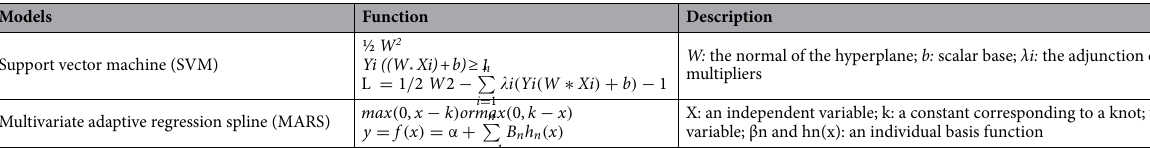
Table 11. The function of models and their